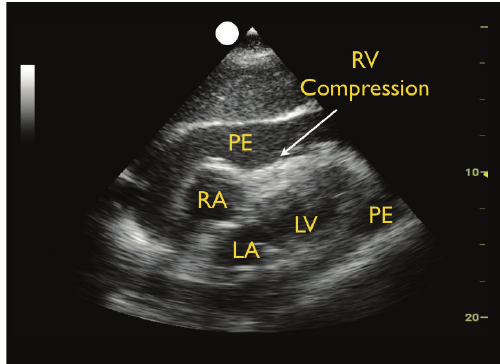
Figure 5: Cardiac tamponade, subxiphoid view. RV: right ventricle, RV: right atrium, LV: left ventricle, LA: left atrium, PE: pericardial e ff